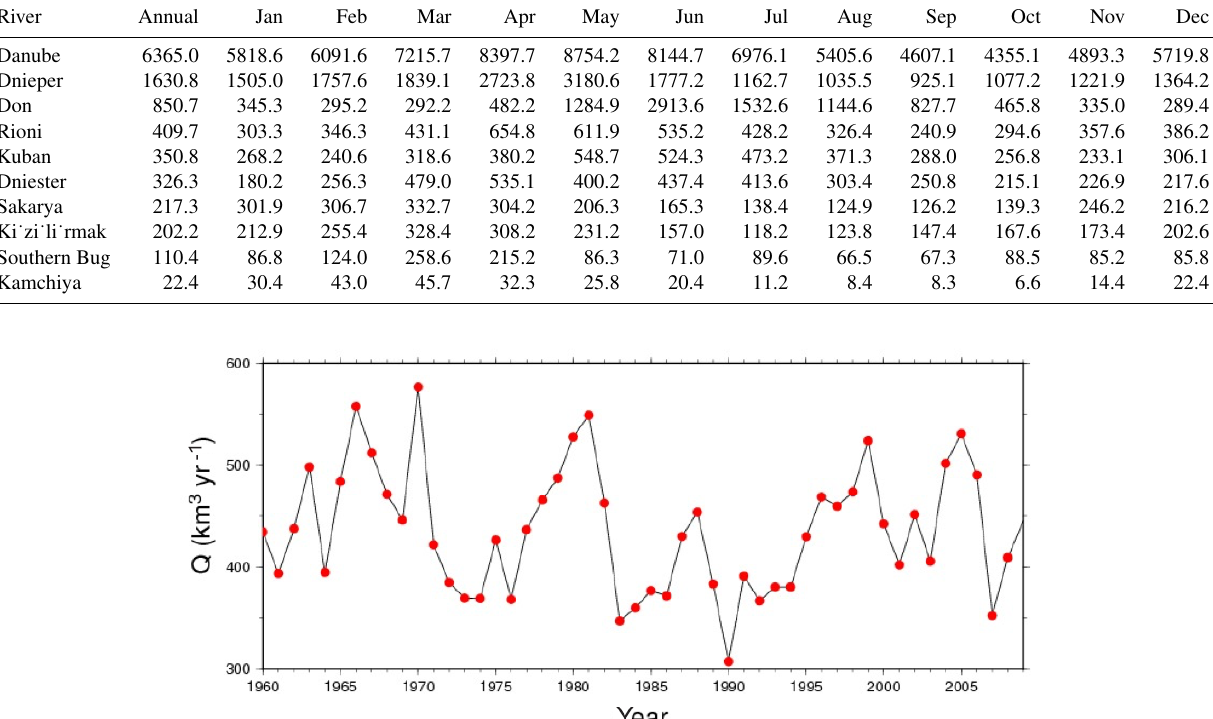
Figure 3. Interannual variations of mean annual freshwater inflow to the Black Sea – source: GRDC (https://www.bafg.de/GRDC/EN/Home/ homepage_node.html, last access: 11 January